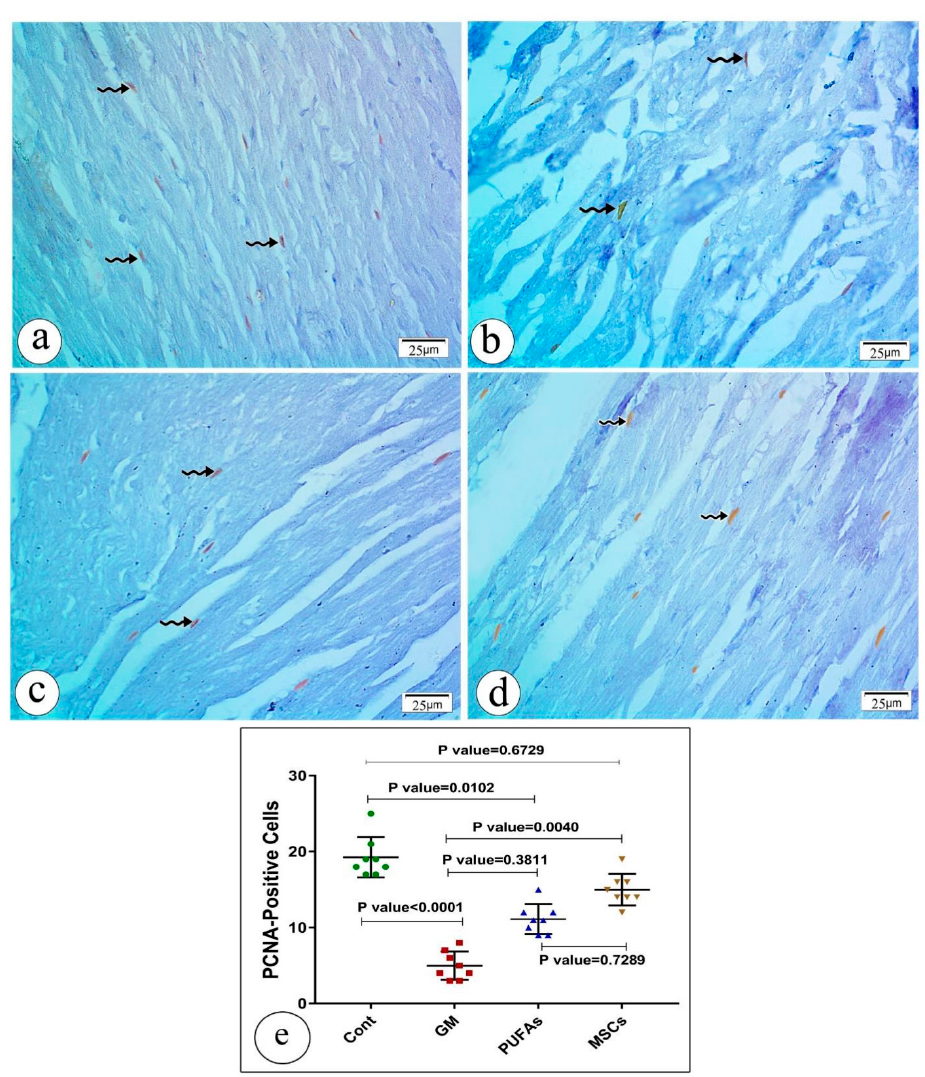
Figure 7. Immunostained sections of heart tissue PCNA expression in cardiac myocytes in all studied groups. Positive staining is shown by a dark-brown color: ( a ) control group showing moderately positive PCNA immunoreactivity in some myocytes (wavy arrow); ( b ) gentamycin-treated group showing almost absent PCNA immunoreactivity expression (wavy arrow); ( c ) gentamycin- and PUFA-treated group showing moderately positive immunoreactivity( wavy arrow); ( d ) gentamycin- and MSC-treated group showing moderately positive PCNA immunoreactivity almost similar to the control (wavy arrow). ( e ) Statistical analysis of PCNA expression in cardiac myocytes in all groups studied. Nonparametric statistics were used. Data were analyzed using the Kruskal–Wallis test followed by Dunn’s test. Results are expressed medians and interquartile ranges. Differences were considered significant at p < 0.05.